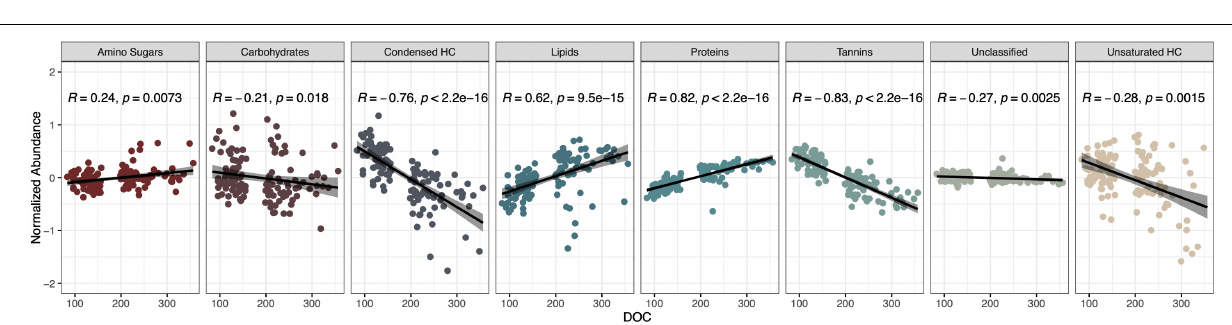
FIGURE 3 | Proteins and tannins are the compound classes most strongly correlated with DOC concentration. Spearman correlation coefficients ( R ), R 2 -values, and p -values are